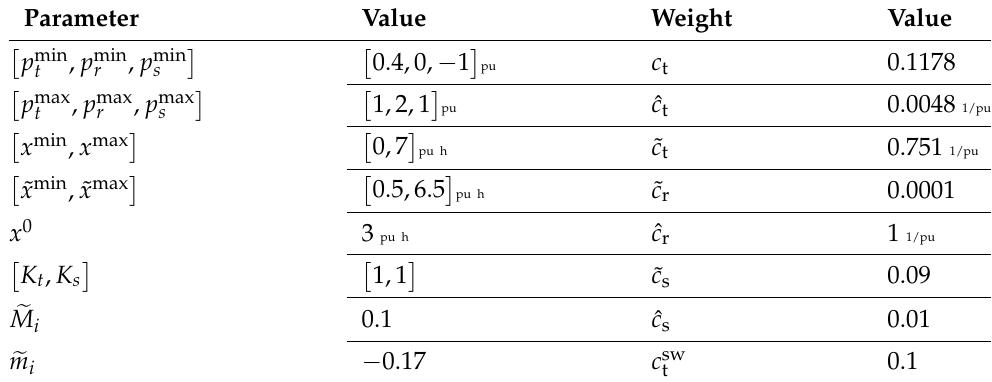
Table 2. Parameters of the microgrid test